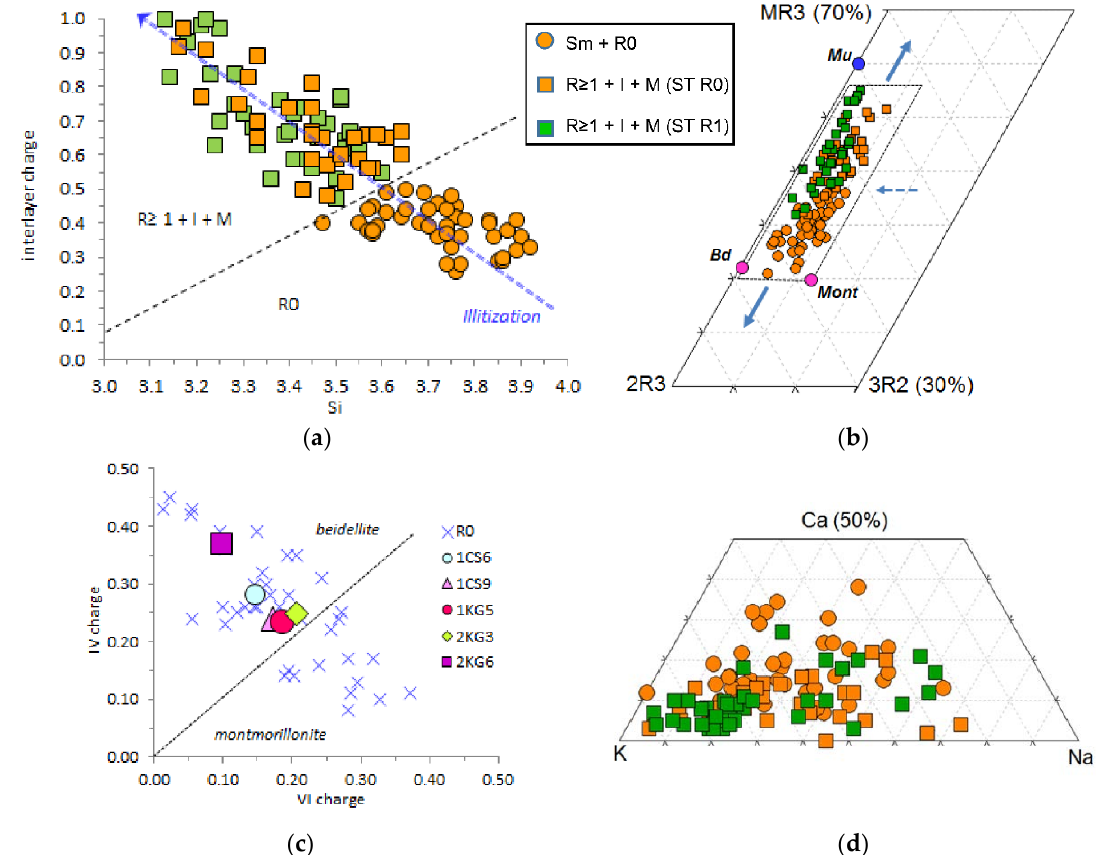
Figure 8. Plots of AEM analyses of dioctahedral clays: Smectite and R0 I/S mixed layers and R ≥ 1 + illite + mica phases of the R0 and R1 stages of diagenesis: ( a ) Si vs interlayer charge; ( b ) MR3 - 2R3 - 3R2 ternary diagram of Velde (1985); ( c ) smectite (R0) layer charge based on the structural formula obtained by AEM (X: individual particle analysis; other symbols: average values for each sample); ( d ) ternary diagram showing the content in interlayer